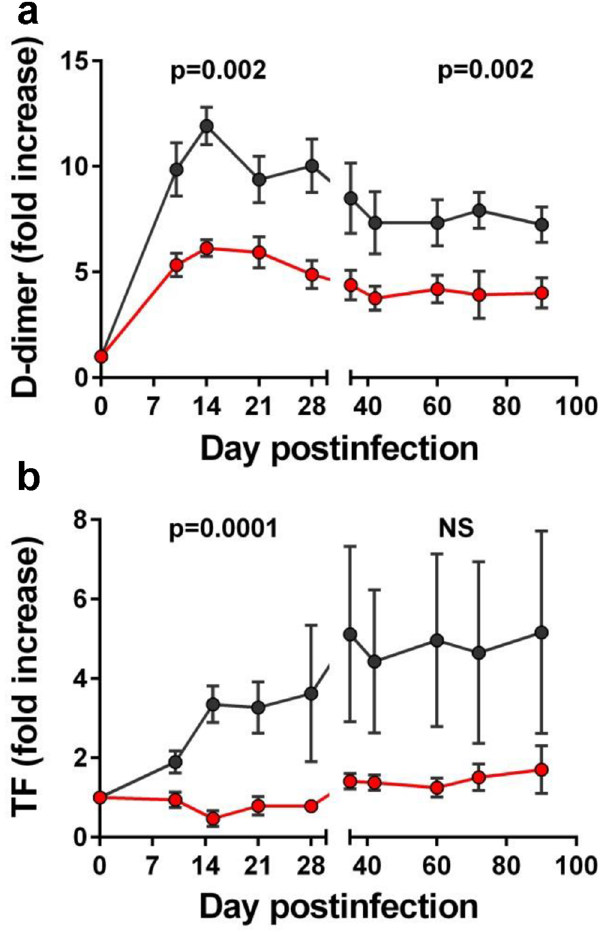
Fig 6. Rifaximin (RFX) + sulfasalazine (SFZ) therapy reduces the levels of coagulation biomarkers during acute and early chronic SIVsab infection of pigtailed macaques (PTMs). Levels of D-dimer (a) and tissue factor (b) were significantly lower in SIVsab-infected PTMs receiving RFX+SFZ (red) compared to untreated controls (black). Shown are the average values for each group and standard error of